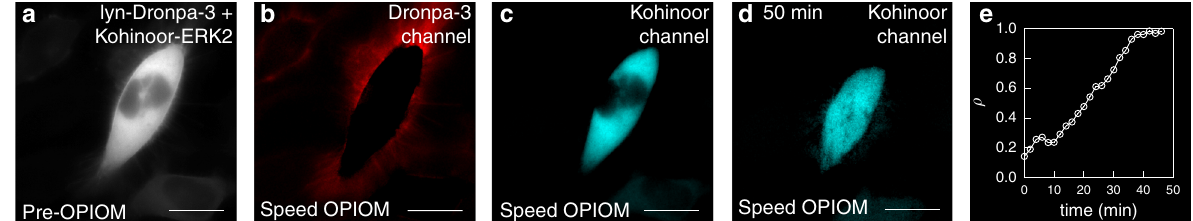
Fig. 5 Speed OPIOM can track quantitatively fast biological processes. Live HeLa cells expressing MEK1, Kohinoor-ERK2 (initially located in the cytoplasm) and Lyn11-Dronpa-3 before ( a – c ) and after ( d ) addition of epidermal growth factor ( EGF ). The fi gure in e displays the temporal evolution of the absolute value of the ratio ρ of the speed OPIOM Kohinoor signals in the nucleus and in the cytoplasm. Pre-OPIOM and speed OPIOM images tuned to the resonance of Dronpa-3 and Kohinoor ( a – e ). Localizations: Lyn11 (cell membrane). The images were recorded at 37 °C. Scale bars : 20 µ m. See